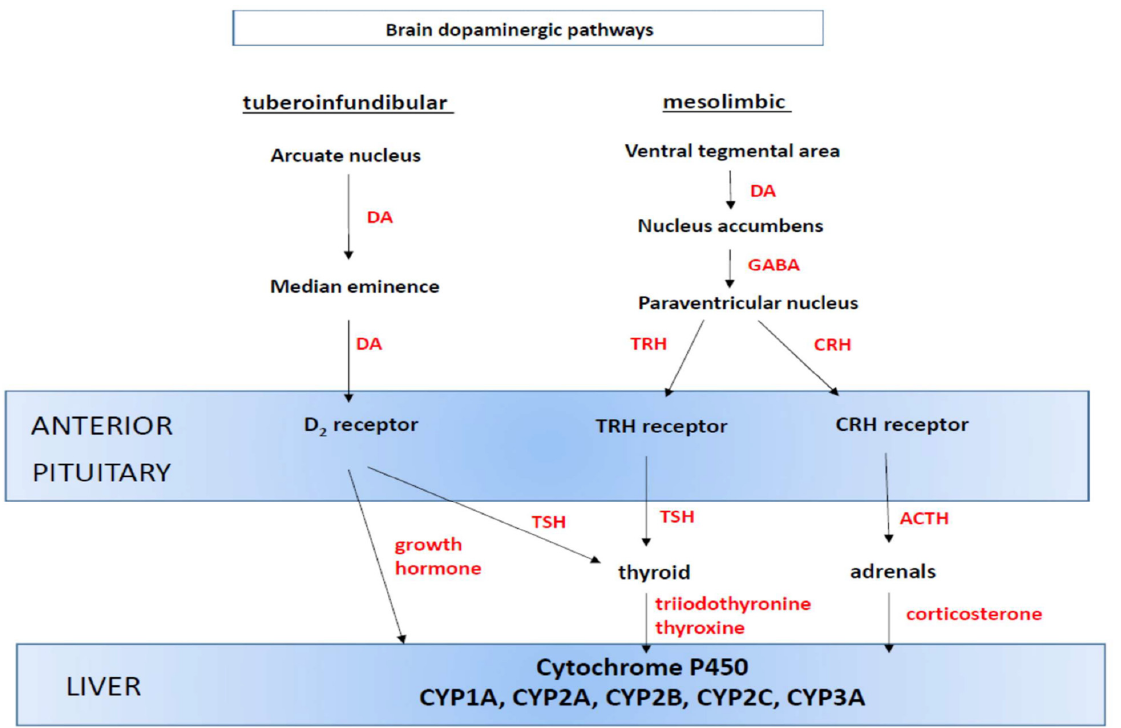
Figure 1. Neuroendocrine regulation of hepatic cytochrome P450 involving the brain dopaminergic system in rats (based on [41]). ACTH, adrenocorticotropic hormone; CRH, corticotropin-releasing hormone; DA, dopamine; GABA, gamma-aminobutyric acid; TRH, thyrotropin-releasing hormone; TSH, thyroid-stimulating hormone. Mesolimbic pathway: dopamine released from dopaminergic neurons projecting from the ventral tegmental area to the nucleus accumbens activates D 2 receptors in the nucleus accumbens, the latter projecting to the hypothalamus containing paraventricular nuclei producing TRH and CRH. TRH and CRH stimulate the release of TSH and ACTH from the anterior pituitary, respectively. TSH stimulates thyroid hormone secretion whereas ACTH activates adrenal corticosterone secretion. Tuberoinfundibular pathway: dopaminergic neurons project from the arcuate nuclei of the hypothalamus to the median eminence, from where dopamine is transported via circulation to the anterior pituitary and activates D 2 receptors present therein, and thus growth hormone and TSH secretion. Growth hormone, thyroxine, triiodothyronine and corticosterone reach the liver via blood circulating and regulate cytochrome expression. Wójcikowski and Daniel [41,42] showed that the activation of these brain dopamin- ergic pathways was significant to the regulation of liver cytochrome P450, namely CYP1A, CYP2B, CYP2C11 and CYP3A in rats (Table 1). Activation of the tuberoinfundibular path- way leading to the stimulation of pituitary dopaminergic receptors (by D 1 /D 2 receptor ag- onist) caused a significant increase in the activities and protein levels of CYP2B, CYP2C11 and CYP3A, accompanied by a substantial increase in growth hormones and a decrease in T3 concentration in the blood plasma. On the other hand, activation of the mesolimbic pathway by stimulation of dopaminergic receptors in the nucleus accumbens by apomor- phine (D 1 /D 2 receptor agonist), amphetamine (releasing dopamine and inhibiting dopa- mine re-uptake) or quinpirole (D 2 receptor agonist) resulted in the increased activity and protein levels of CYP3A, accompanied by a simultaneous large increase in the concentra- tion of corticosterone and a moderate decrease in that of T 3 . Moreover, the activation of the tuberoinfundibular or mesolimbic pathways considerably decreased the activity and protein levels of CYP1A [42]. Damage to these dopaminergic pathways produced oppo- site effects in rats [43]. Lesion of the tuberoinfundibular pathway decreased the activity